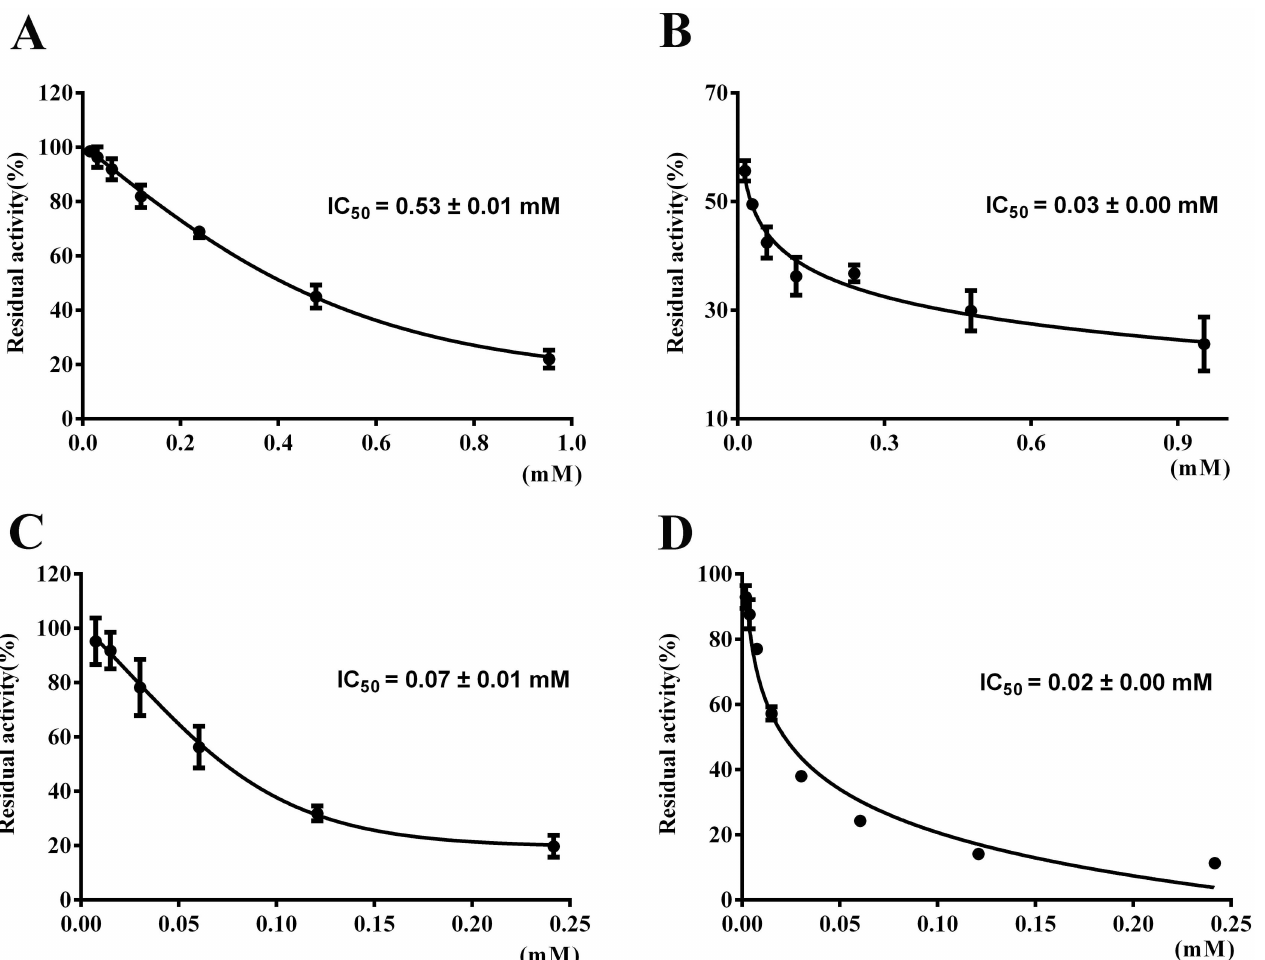
Fig 2. Effect of Pal on the activities of HPU and JBU. HPU was treated with Pal ( A ) and AHA ( C ); JBU was incubatedwith Pal ( B ) and AHA ( D ). The residualactivity was calculatedas percent of the control activity. The results summarized here are the mean values ± SD from three independent